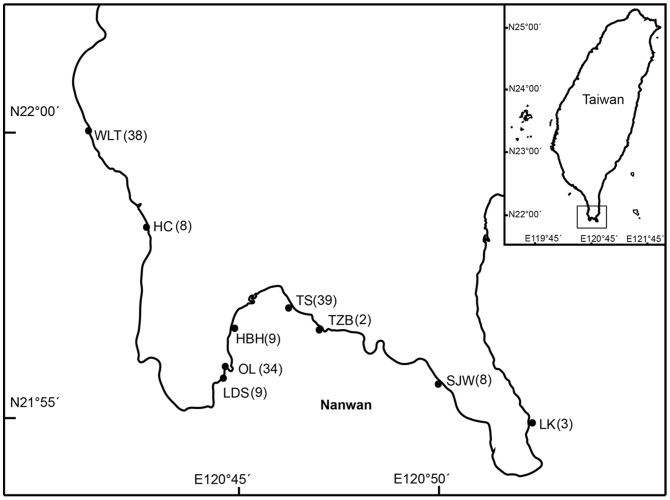
Map of study sites in southern Taiwan.The number of retrieved plates is indicated in parentheses. Abbreviations of sites: WLT, Wanlitung; HC, Hungchai; LDS, Leidashih; OL, outlet of warm water discharge from nuclear power plant; HBH, Hobihu; TS, Tiaoshi; TZB, Tantzei Bay; SJW, Shinjaowan; LK, Longkeng.